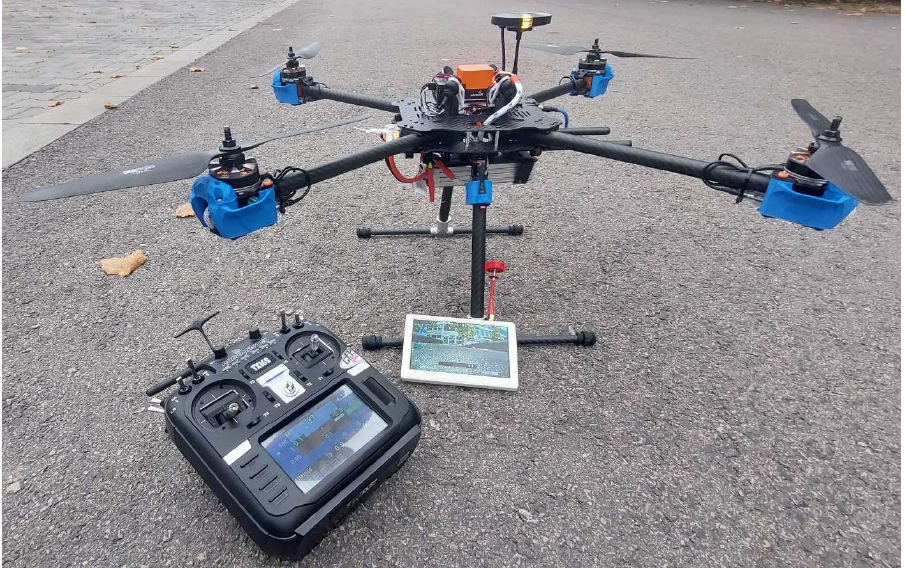
Figure 1. The completed UAV.